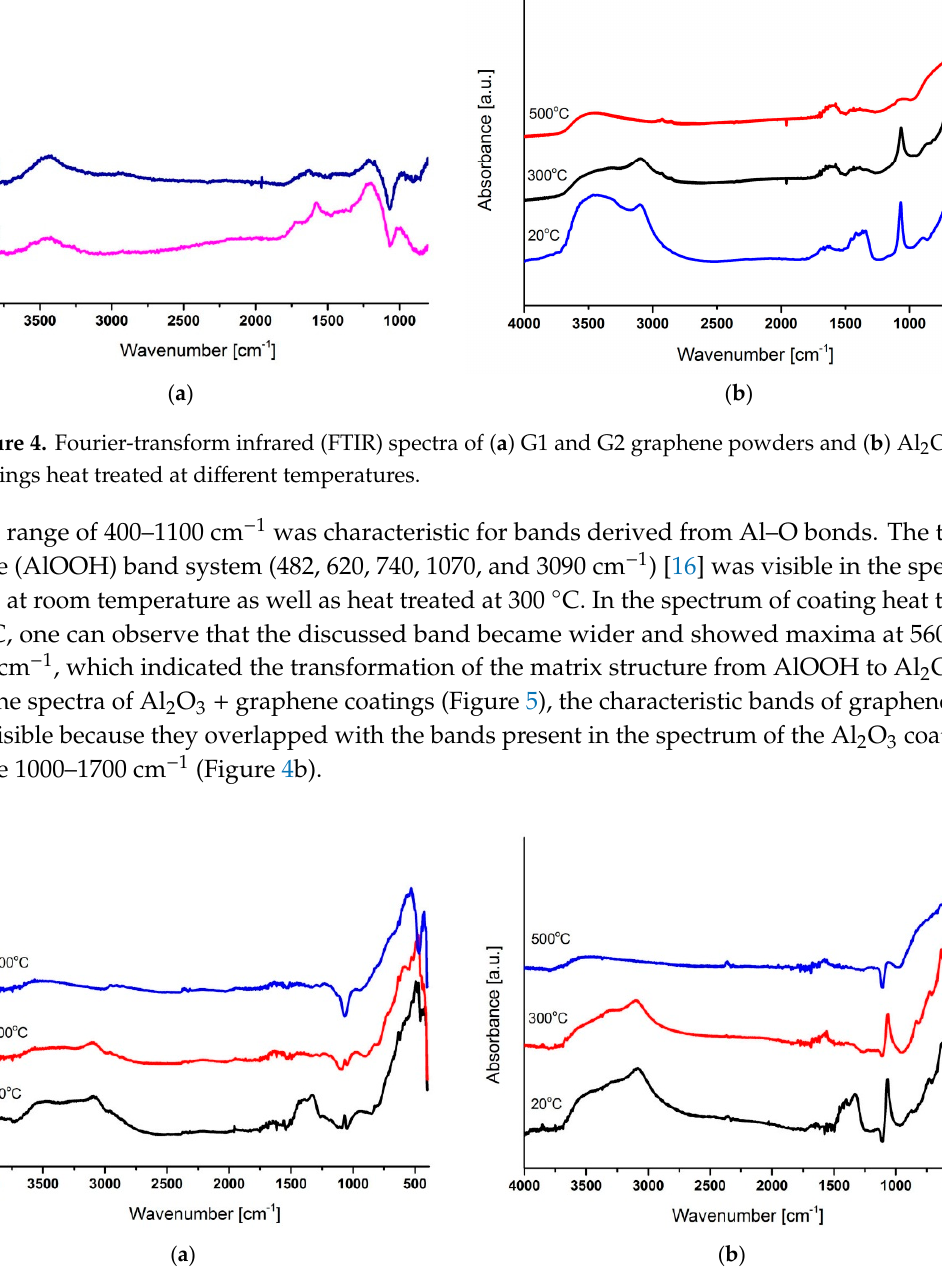
Figure 5. FTIR spectra of Al 2 O 3 + graphene coatings with ( a ) G1 graphene and ( b ) G2 graphene, heat treated at different temperatures.